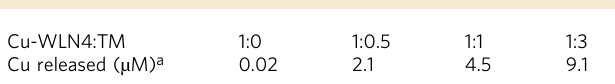
Table 2 Copper released from Cu-WLN4 in the reaction with TM